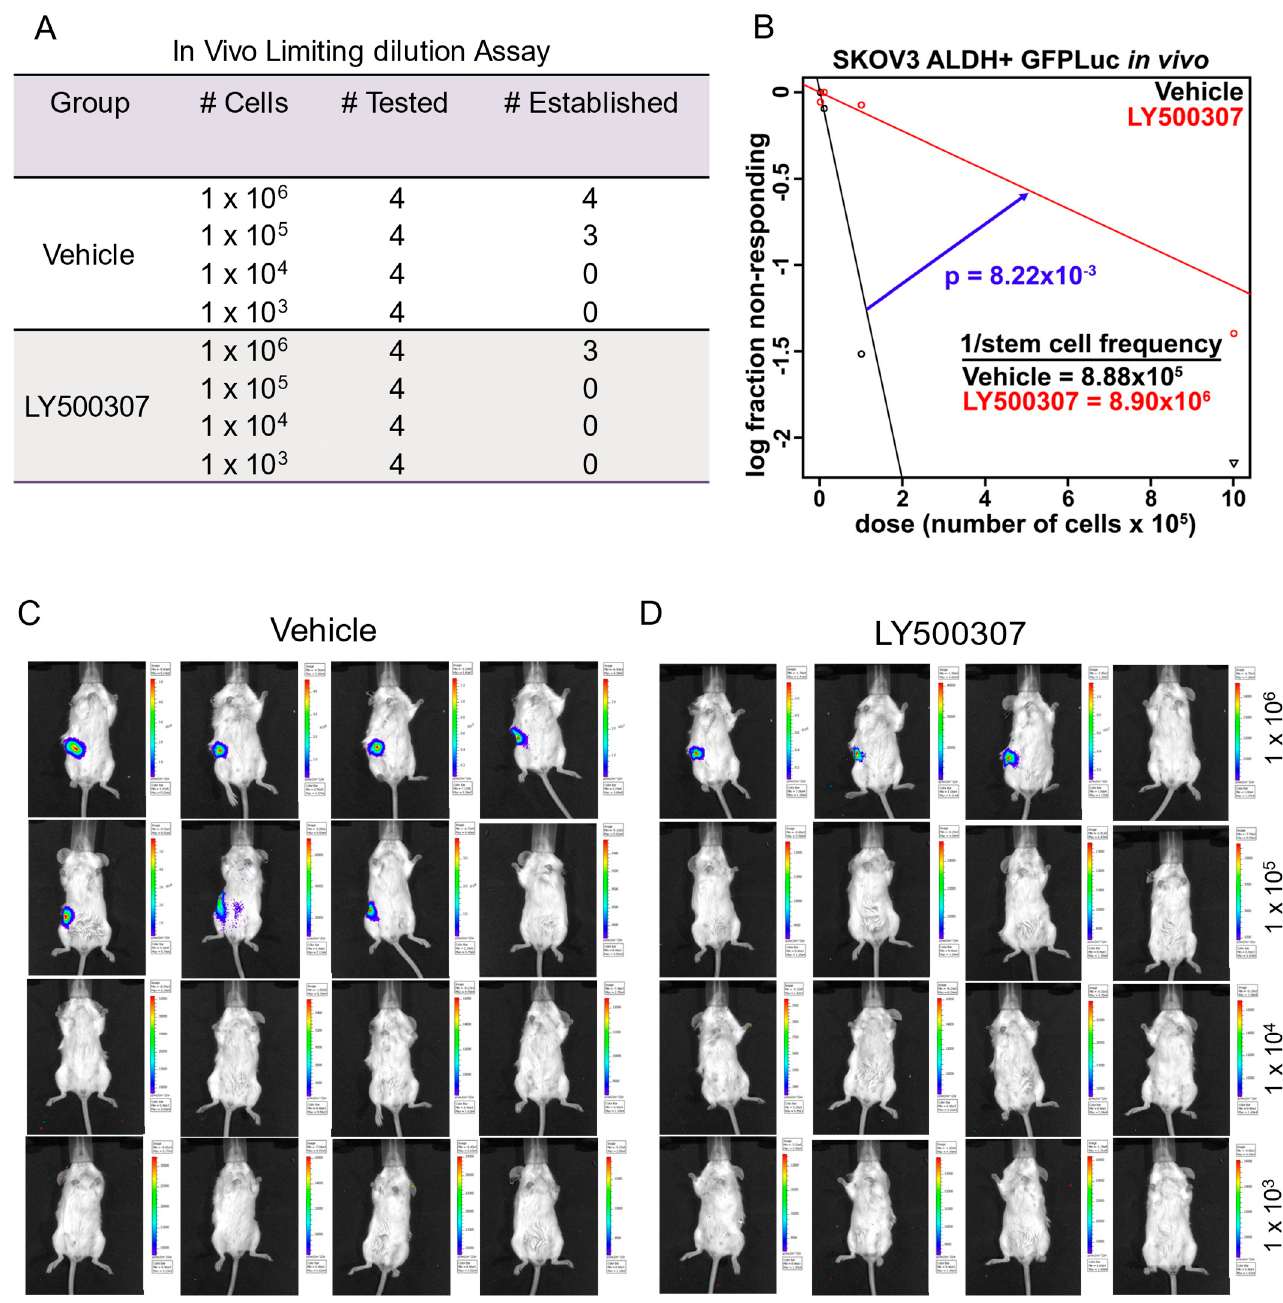
Figure 5. LY500307 treatment reduced the tumor initiation capacity of OCSCs. SKOV3 ALDH+ve cells that stable expressing GFP-Luc were treated with vehicle or LY500307 for 72 h, and the varying number of viable cells were injected into ovarian bursa. Mice were monitored for tumor establishment for 30 days and imaged weekly using Xenogen in vivo imaging system. ( A ) Table showing the mice per each group and number of mice with tumor establishment. ( B ) ELDA analysis was performed to estimate the tumorigenic capacity of OCSCs. ( C , D ) Pictures of the mice at the end of the experiment were shown.